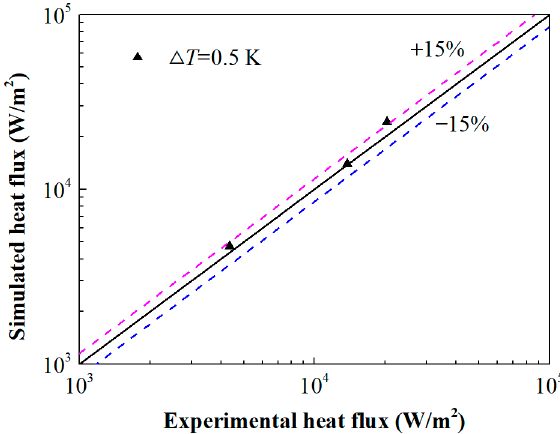
Figure 2. Comparison between the simulation results and the experimental data.